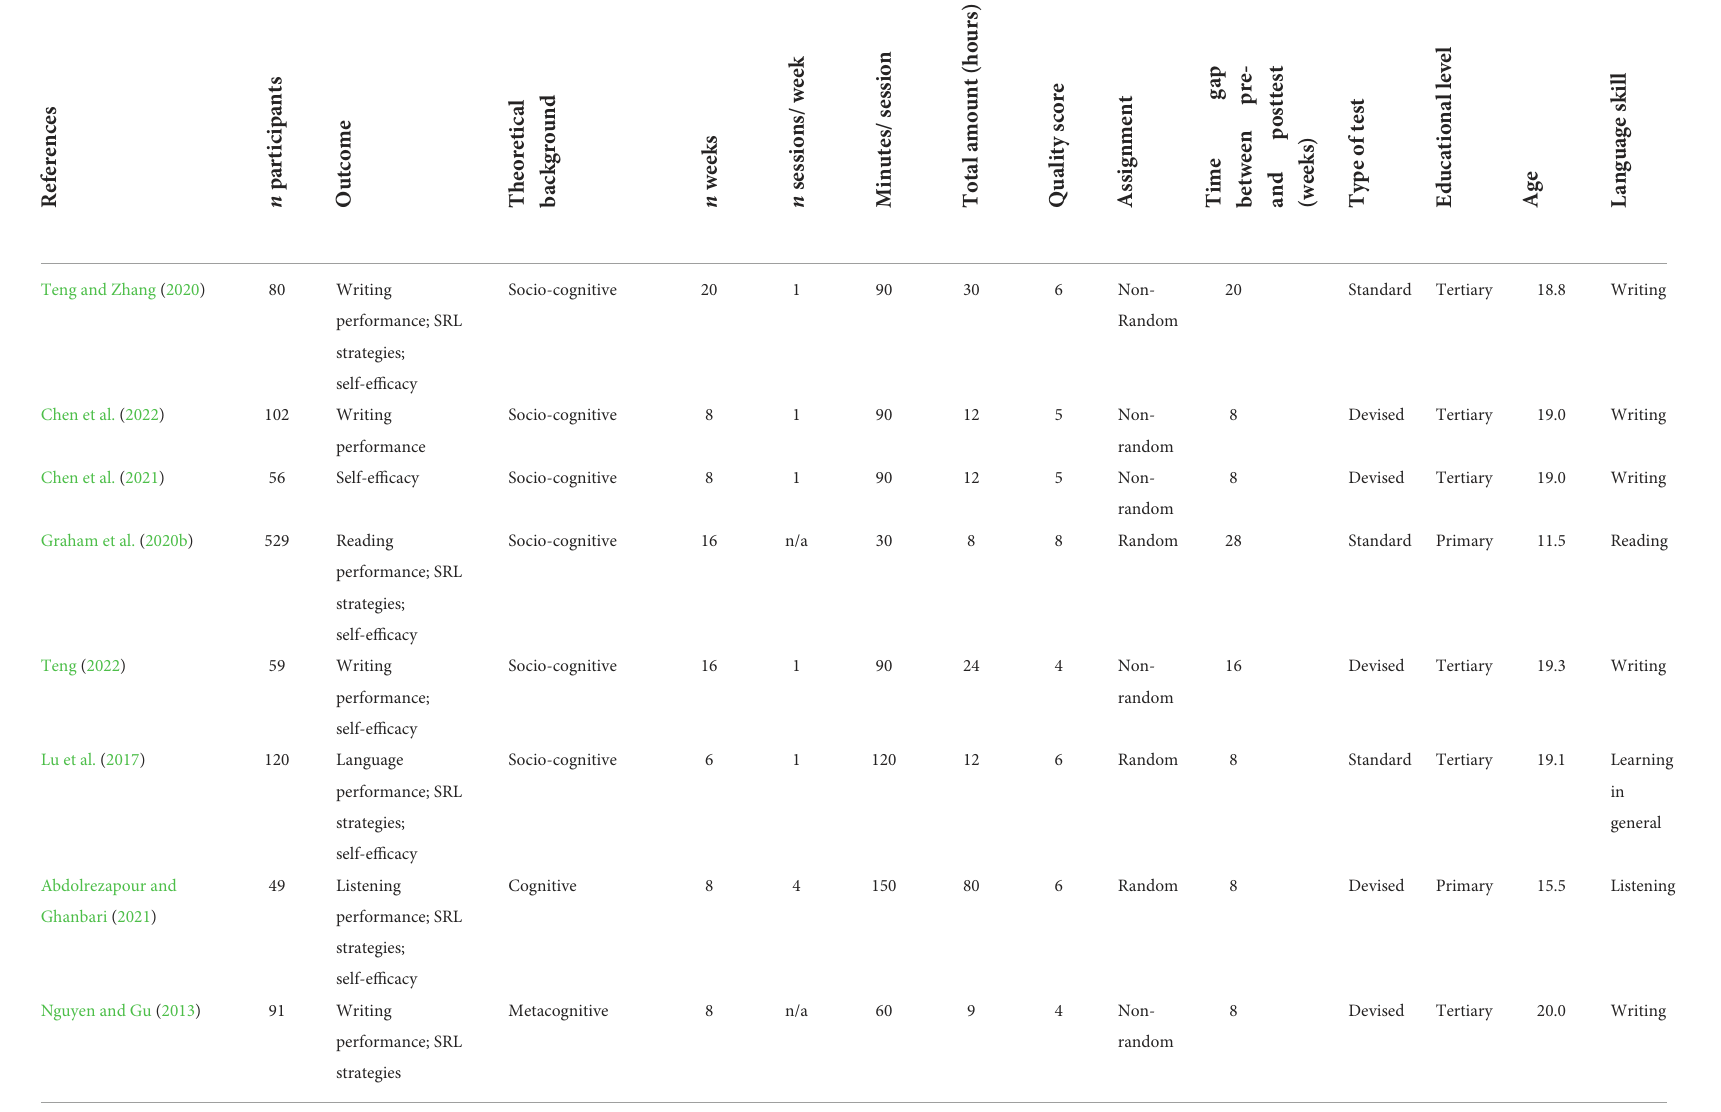
TABLE 1 Coding information of studies included in the